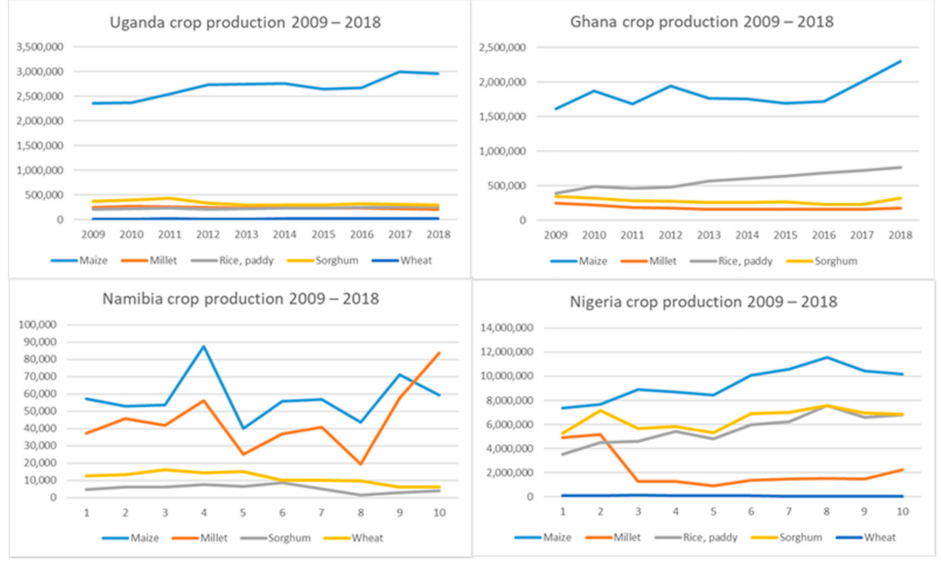
Figure 3. Trends of cereal crop production in target countries